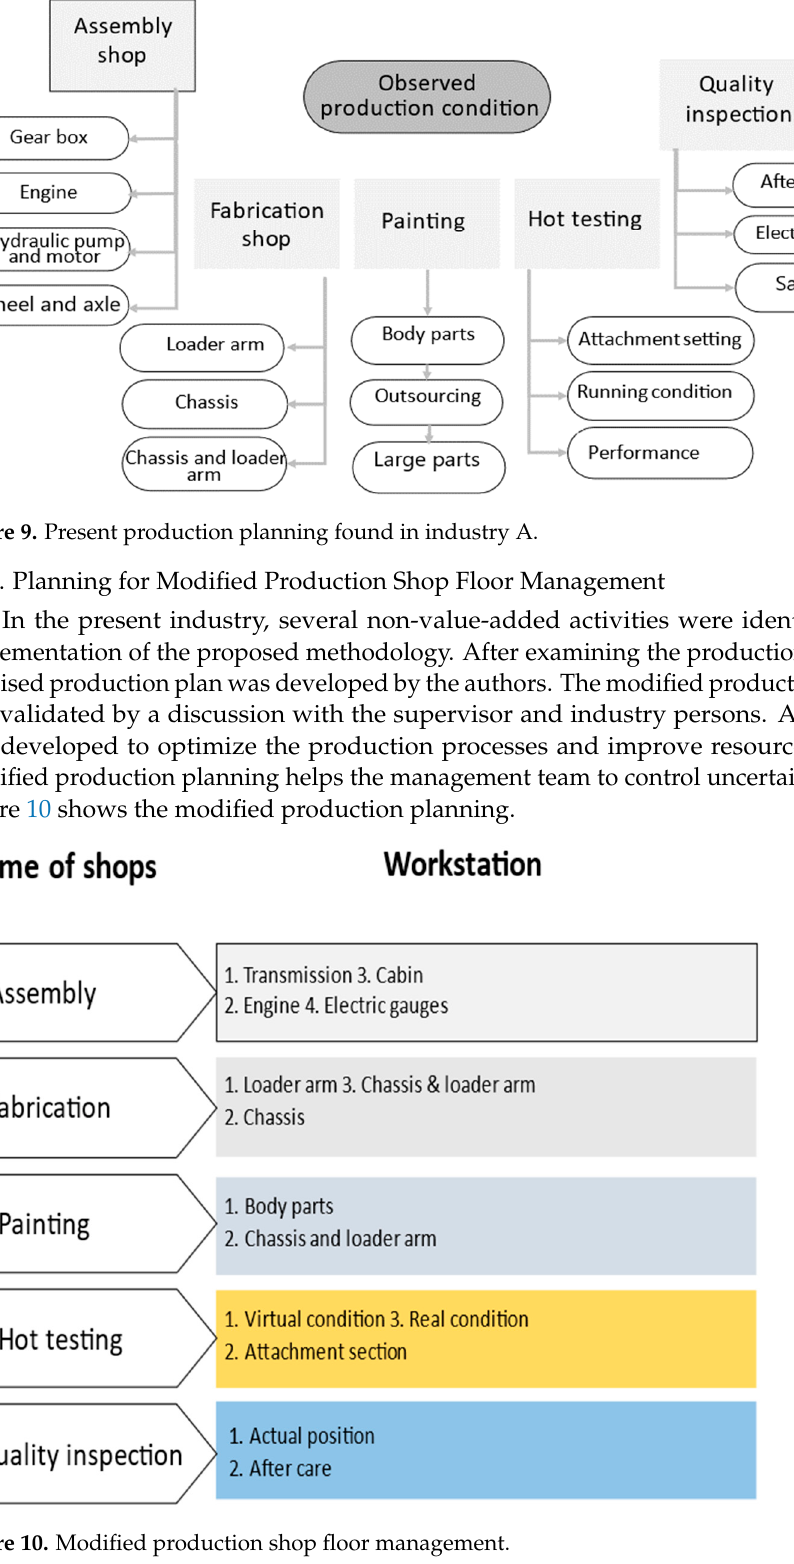
Figure 10. Modified production shop floor management.